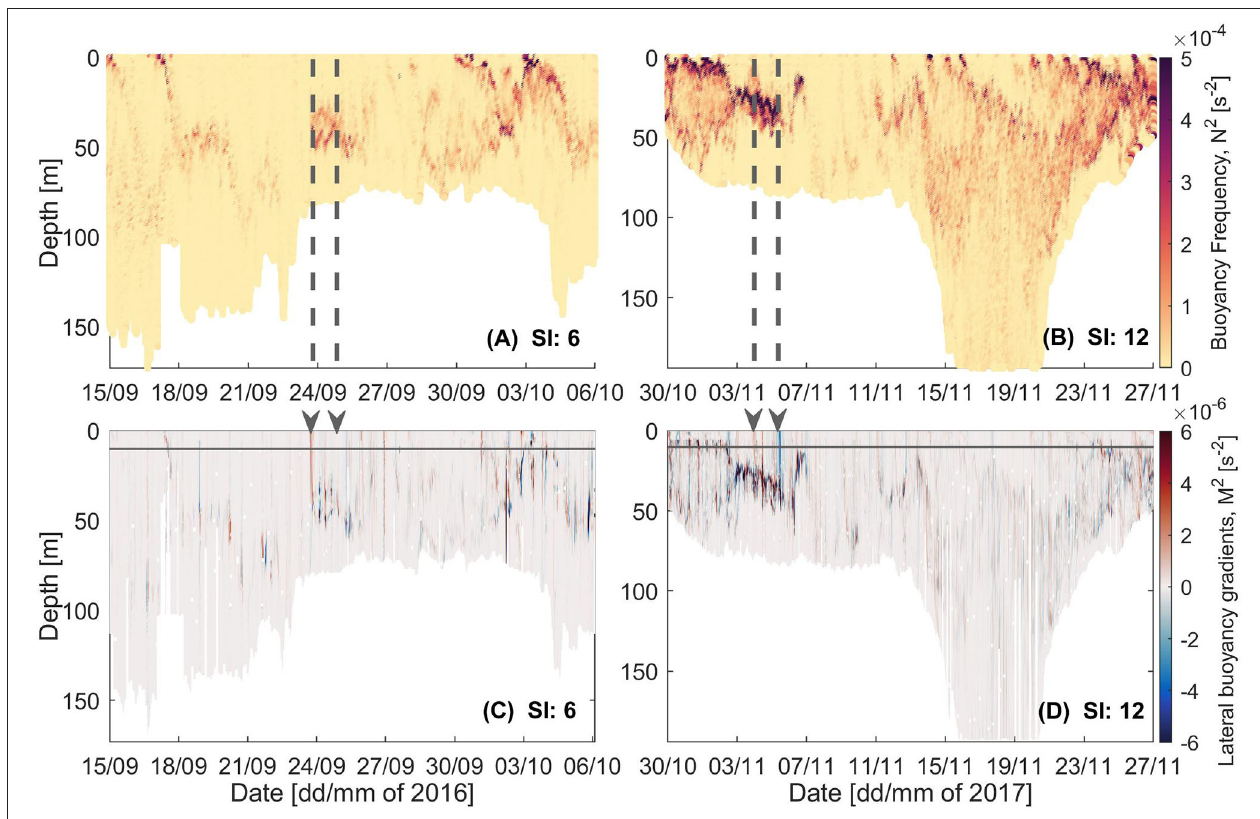
FIGURE 4 | (A,B) Buoyancy frequency and (C,D) lateral buoyancy gradients for glider Survey Indexes 6 and 12. Start and end of LSMFs as sampled by glider for the two surveys denoted by (A,B) gray dashed lines and (C,D) gray arrows. Gray solid line indicates the depth to which density was interpolated horizontally across profiles with missing shallow values, due to the glider diving